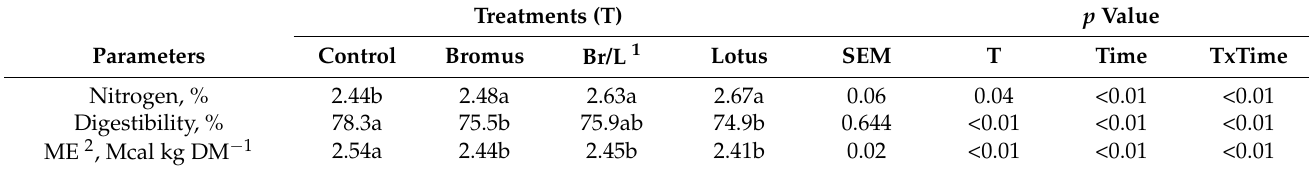
Table 2. Chemical composition of forage species used in the experiment.